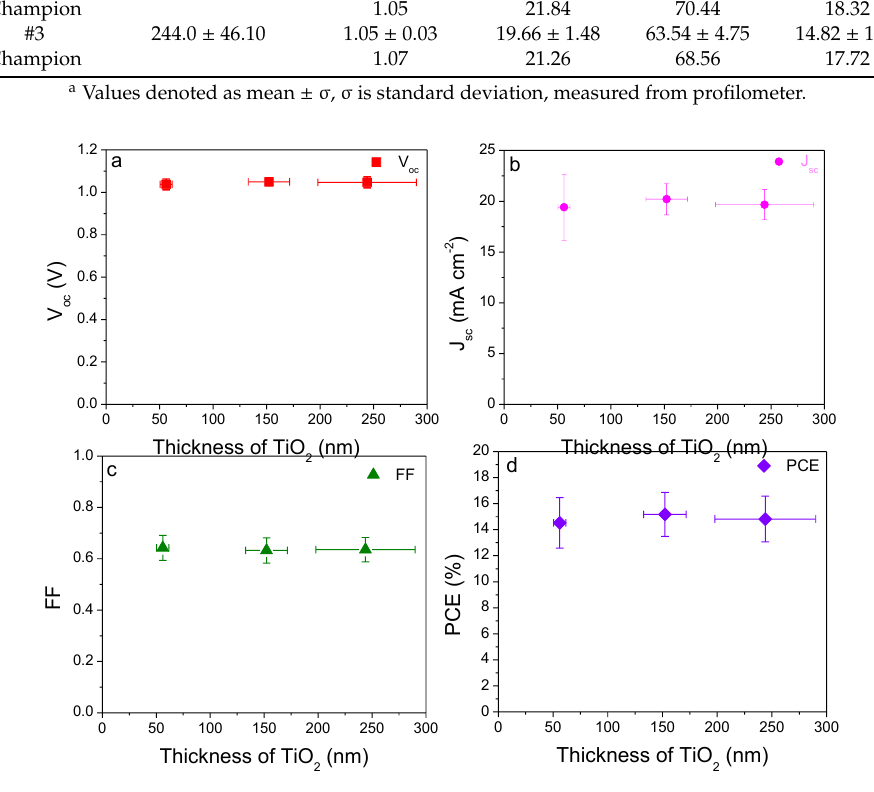
Figure 2. Photovoltaic parameters as a function of thickness of the electron transport layer (ETL) TiO 2 . ( a ) open-circuit voltage ( V oc ) ( b ) short-circuit current density ( J sc ), ( c ) fill factor (FF) and ( d ) power conversion efficiency (PCE). Table 1. Photovoltaic parameters of the assembled planar PSCs with a typical configuration of FTO/TiO 2 /MAPbI 3 /Spiro-MeOTAD/Ag.